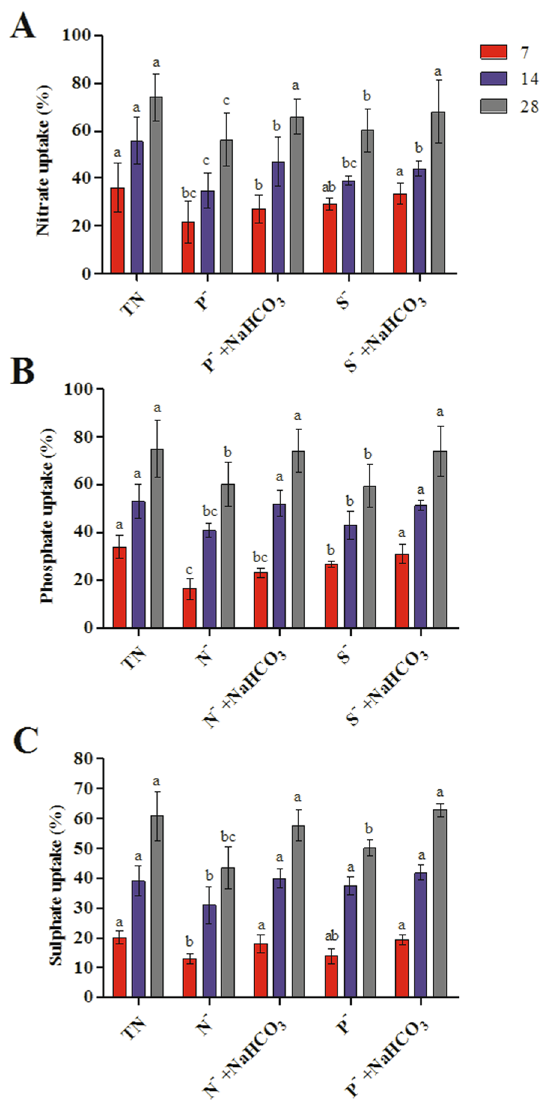
Figure 4. Effect of bicarbonate on nutrient uptake in Dunaliella cells grown under nutrient deficit conditions. ( A ) Nitrate uptake, ( B ) Phosphate uptake and ( C ) Sulphate uptake. All values are expressed as Mean ± SD (n = 3). Values with different letters represent significantly differ at p < 0.05 between the groups. Total Nutrient (TN); Nitrate deficit (N − ); Nitrate deficit with bicarbonate (N − + NaHCO 3 ); Phosphate deficit (P − ); Phosphate deficit with bicarbonate (P − + NaHCO 3 ); Sulphate deficit (S − ); Sulphate deficit with bicarbonate (S − + NaHCO 3